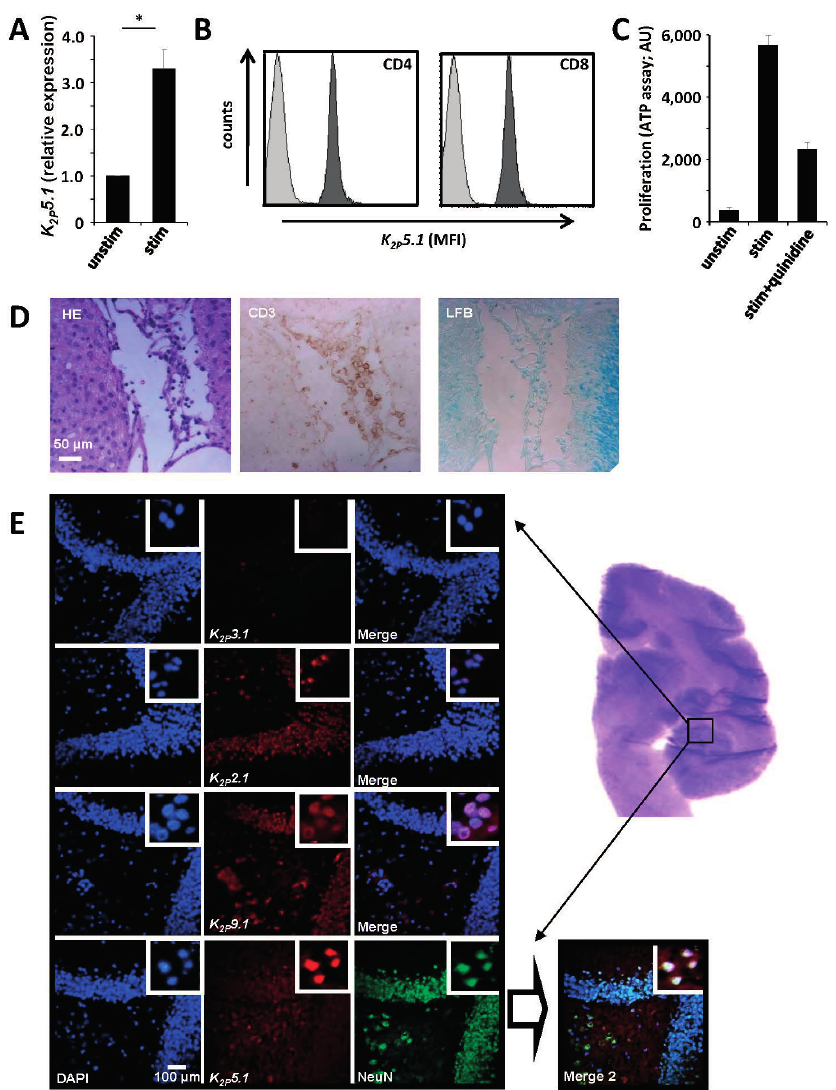
Figure 4. Expression of K 2P 5.1 channels in immune cells and CNS neurons in the common marmoset. ( A ) RT-PCR experiments show that CD4 + T lymphocytes from the common marmoset express K 2P 5.1 in RT-PCR experiments, which is upregulated upon stimulation with PHA ( n = 3); ( B ) CD4 + and CD8 + T lymphocytes express K 2P 5.1 protein as assessed by flow cytometry (one representative example out of three is shown); ( C ) The K 2P 5.1 inhibitor quinidine (20 µM) reduces the proliferation of stimulated marmoset CD4 + T lymphocytes ( n = 3); ( D ) EAE lesions in the common marmoset characterized by HE, CD3 and LFB staining; ( E ) Brain samples from naive common marmosets were assessed by immunohistochemical staining for K 2P 2.1, K 2P 5.1 and K 2P 9.1. NeuN was used as a neuronal marker. The region